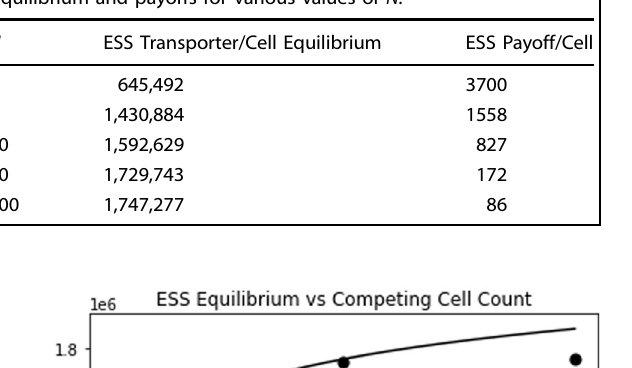
Table 2. Under different levels of crowding, the ESS transporter equilibrium and payoffs for various values of N .